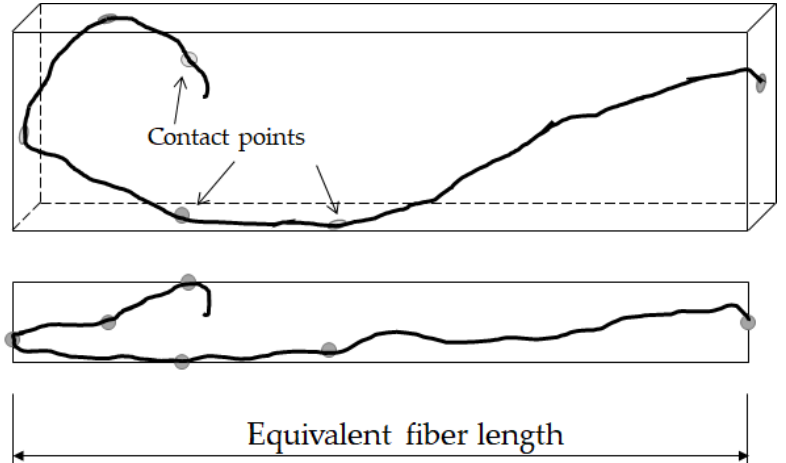
Figure 4. Examples of RSF length characterization: ( a ) from [32]; ( b ) used in this paper.